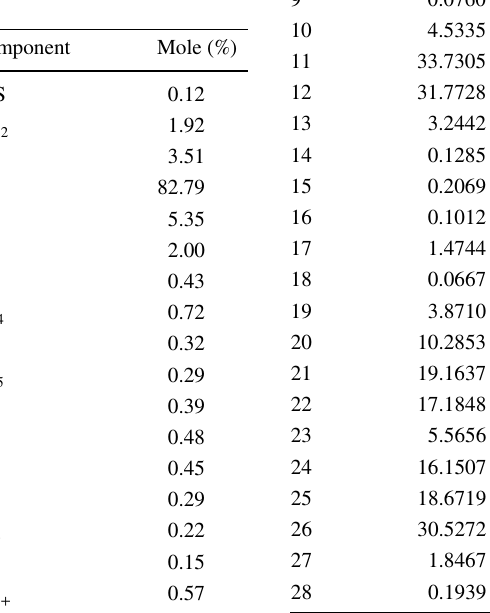
Table 1 Composition of reservoir fluid